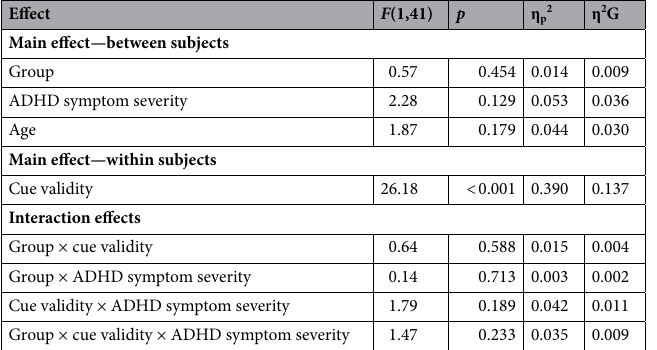
Table 3. The cue validity effect (valid cue vs. invalid cue) and group differences in the cue validity effect on performance accuracy. ADHD: Attention-Deficit/Hyperactivity